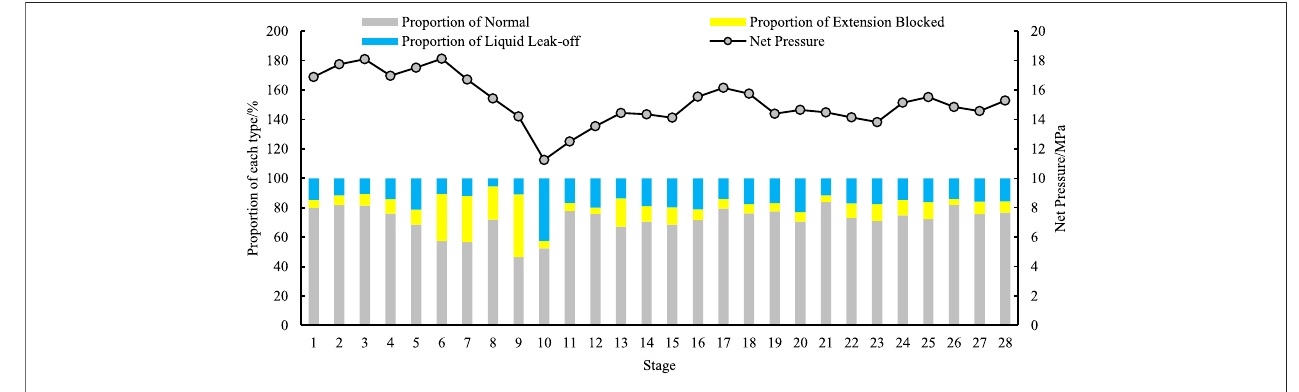
FIGURE 5 | Statistics of the ratio of net pressure, leak-off, and extension time in each stage of well H7 – 4.